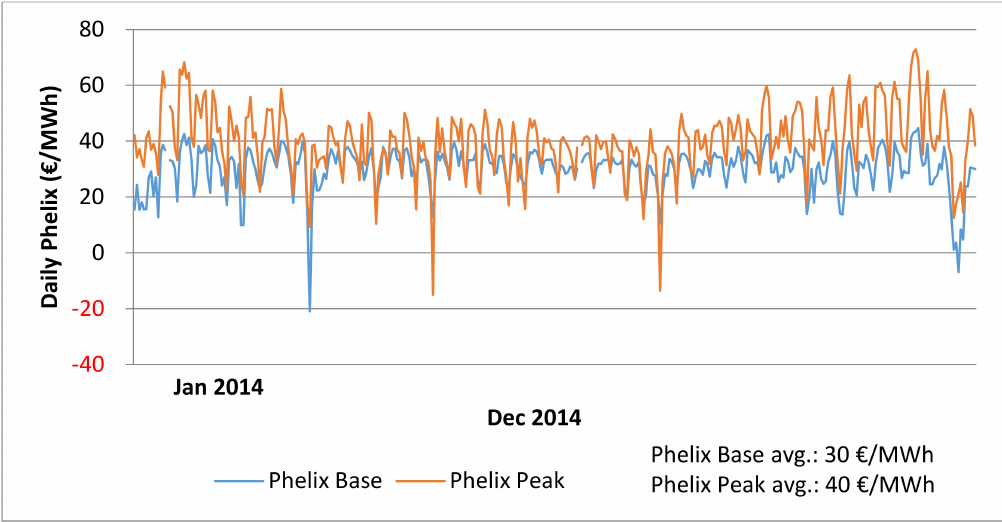
Figure 7. Hourly price forward curve, Phelix Base, and Phelix Peak. Source: own illustration, based on EEX data for 2014 (obtained from